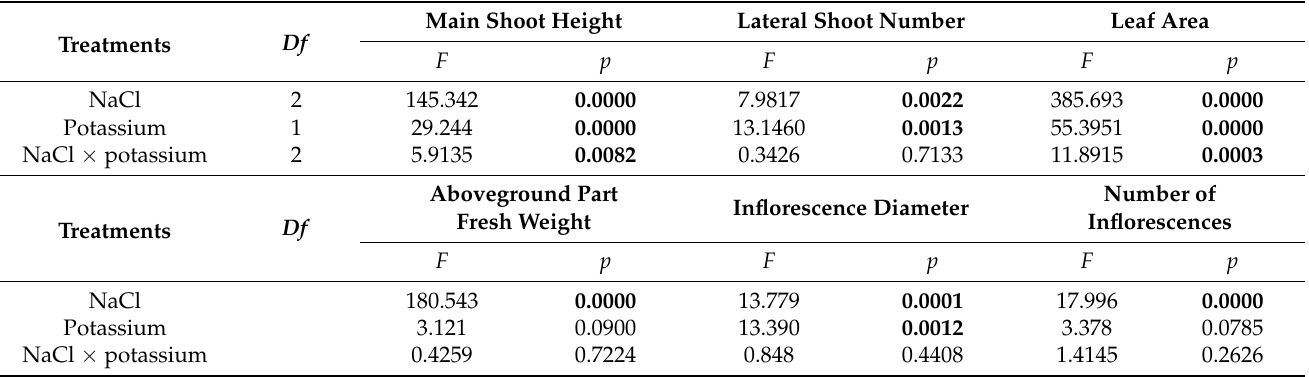
Table 4. ANOVA results for growth parameters in zinnia exposed to salinity with two potassium doses in the peat